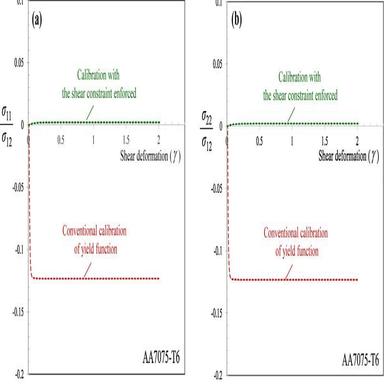
3. Development of normal stresses in simple shear for an anisotropic material (AA7075-T6) with and without the shear constraint of Abedini et al enforced on an associated Yld2000-2d yield criterion. The solution for the conventional calibration is inconsistent with pressure-independent plasticity since the normal stresses have a similar magnitude with the same sign for the loading case considered.